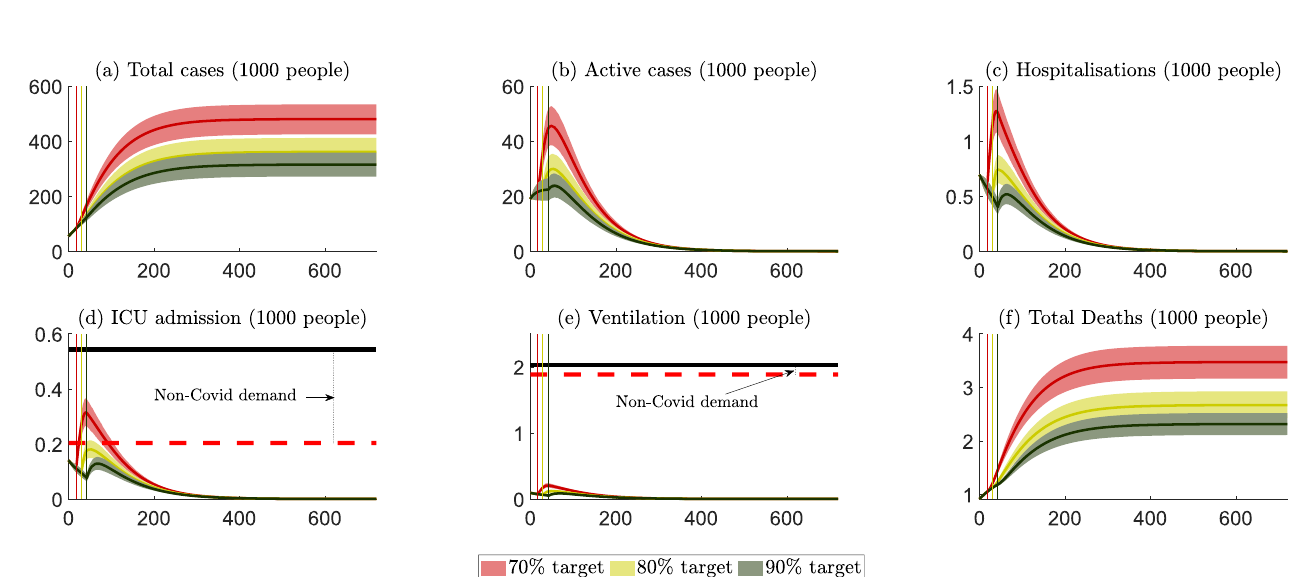
Fig 4. VIC: Projected public health outcomes after opening up. Notes about Fig 4: 1. Day zero is specified to be October 11 th 2021. 2. The red, yellow, and green colours represent scenarios where lockdowns are removed after the 70%, 80% and 90% targets, respectively. 3. The (red, yellow, and green) vertical lines represent the days when the 70%, 80% and 90% targets are reached. 4. The (red, yellow, and green) curves represent the mean of all projection outcomes, and the bands represent their 95% confidence intervals. 5. The black horizontal lines in panels (d) and (e) are the capacity of the health care system, i.e., staffed ICU beds and ventilators (data sources reported in S1 Text). 6. The red horizontal dashed lines in panels (d) and (e) are the net capacity of the non-covid demand for ICU and ventilation, which are estimated via the occupation rates of ICU beds and ventilators in 2018/2019 (data sources reported in S1 Text).